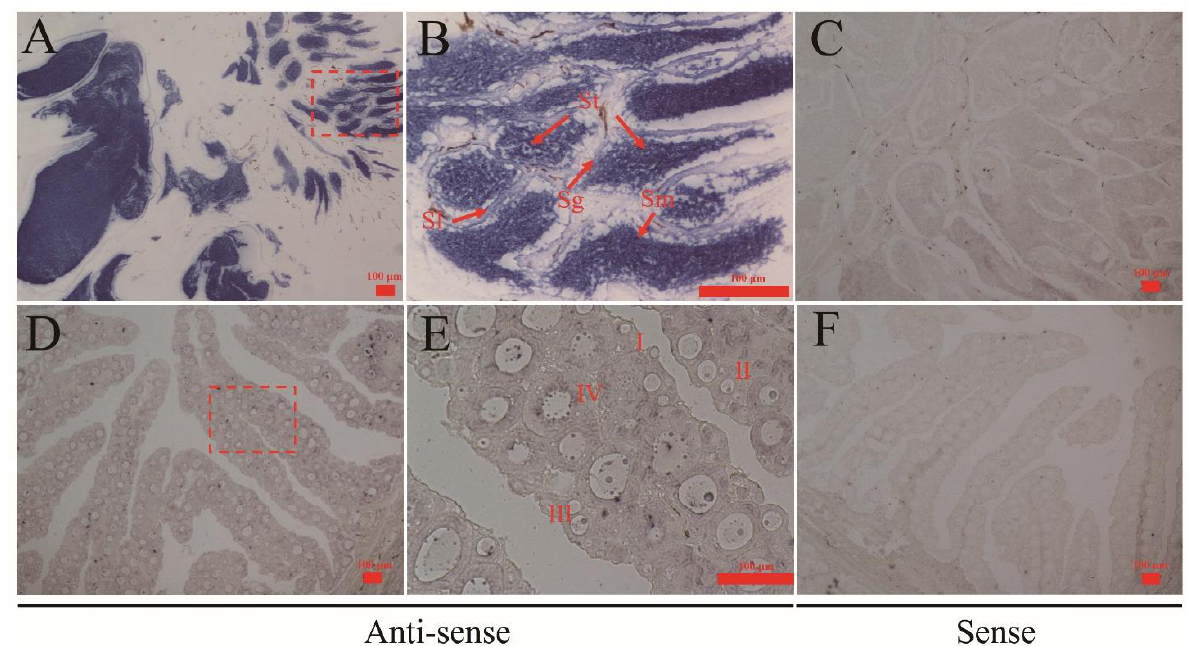
Figure 4. Cellular localization of Cs-rchy1 in 1.5 yph gonads of C. semilaevis . The figure shows the testes ( A – C ) and ovaries ( D – F ). ( A ) testis labelled with Cs-rchy1 antisense probes; ( B ) large magnification of red framed area in ( A ); ( C ) testis labelled with Cs-rchy1 sense probes; ( D ) ovary labelled with Cs-rchy1 antisense probes; ( E ) large magnification of red framed area in ( D ); ( F ) ovary labelled with Cs-rchy1 sense probes. Sg: spermatogonia; St: spermatid; Sm: sperm; Sl: seminal lobule. Oocytes at different developmental stages are marked by I, II, III and IV. Scale bars: 100 μm .